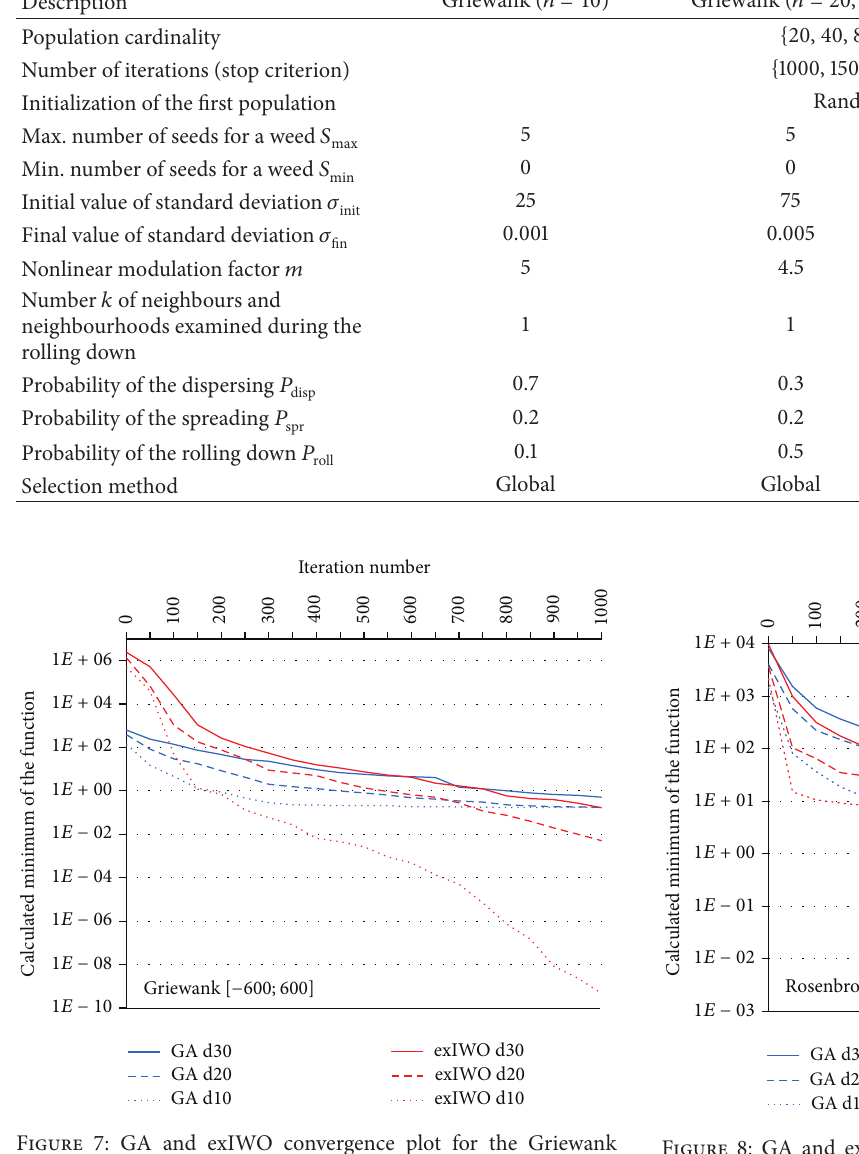
Figure 8: GA and exIWO convergence plot for the Rosenbrock